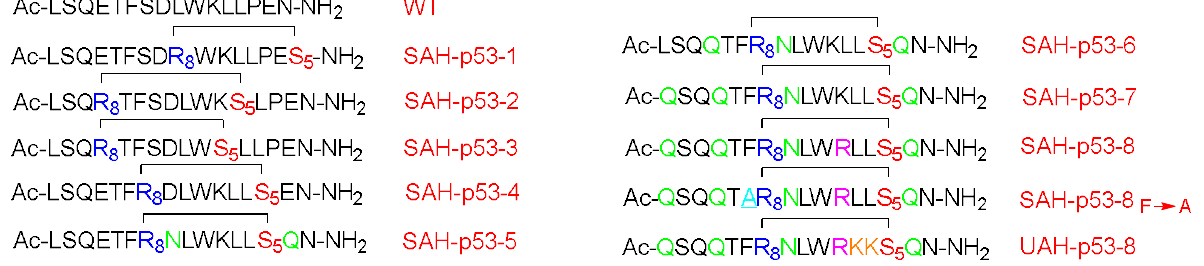
such interactions. The SAHBs peptides showed an enhanced helicity (by CD) from 35 to